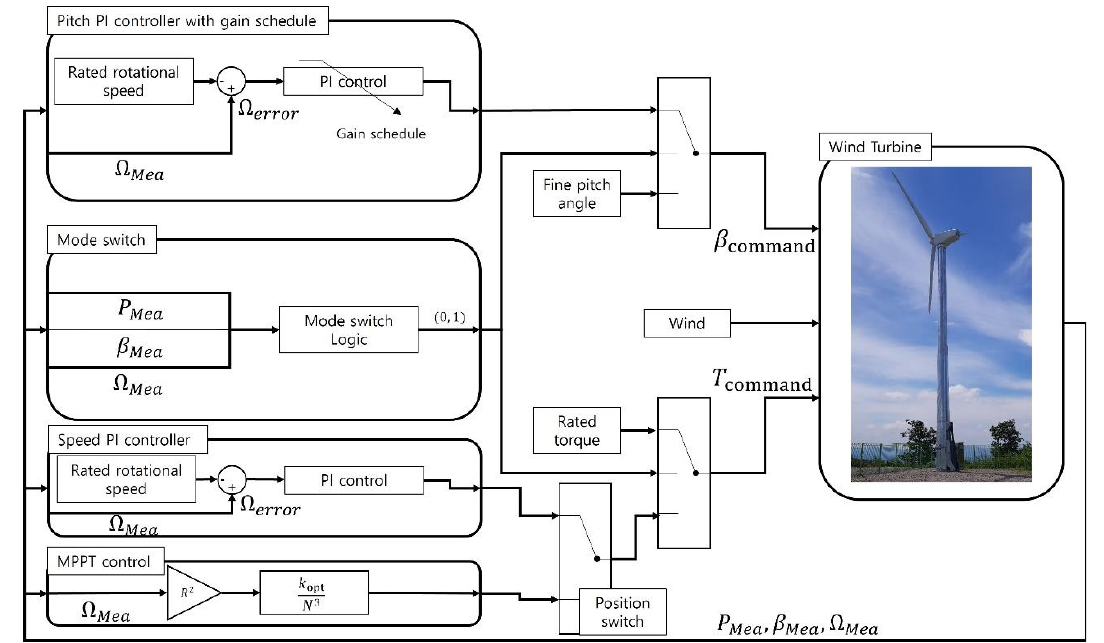
Figure 4. Block diagram of the power control algorithm of variable-speed variable-pitch wind tur- bine.